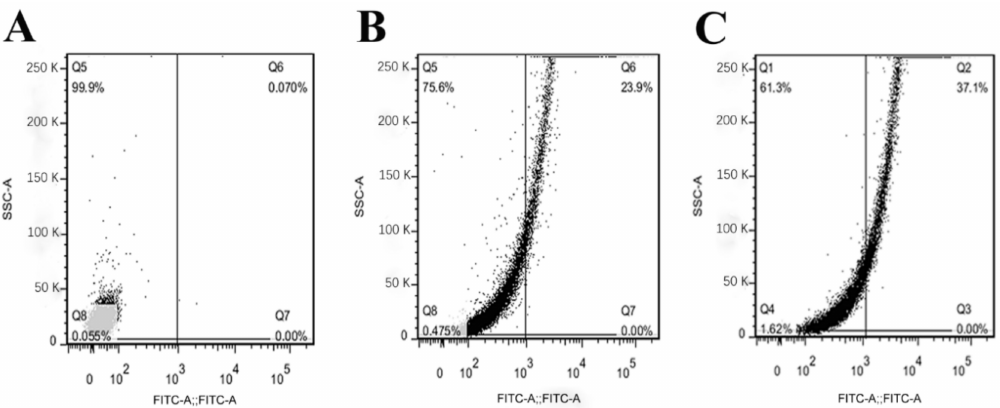
Figure 9. Flow cytometry analysis. Cells in the exponential phase of X. oryzae pv. oryzae ( A – C ) were treated with the peptides and analyzed for cell fluorescence by flow cytometry. The delta fluorescence signal indicates the propidium iodide (PI) uptake caused by peptide treatment. ( A ): no peptide (negative control, 0.07%); ( B ) OrR935 (MIC, 23.9%); ( C ) OrR214 (MIC, 37.1%). The x -axis indicates the average intensity of the fluorescence, and the y -axis displays the light from the side scatter. Experiments under the same conditions were replicated three times, and similar findings were noted.